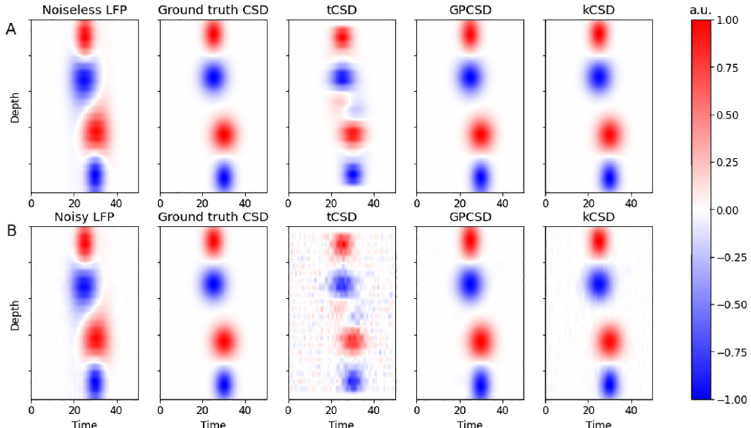
Fig 1. Comparing GPCSD to other methods on simulated CSD dipole. (A) From left to right, ground-truth noiseless LFP, ground-truth CSD pattern, traditional CSD (tCSD) prediction, GPCSD prediction, and kernel CSD (kCSD) prediction. (B) Same as top row, but with noise added to the ground-truth LFP before CSD prediction. GPCSD accurately recovers the pattern compared to tCSD, and appears more robust to LFP noise than either tCSD or